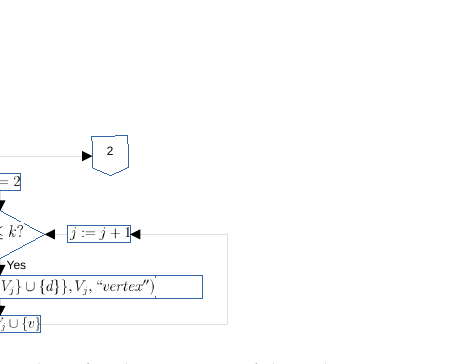
Figure 9. A partial flowchart for the creation of the subsets V j , j = 1, · · · , k with m min vertices.